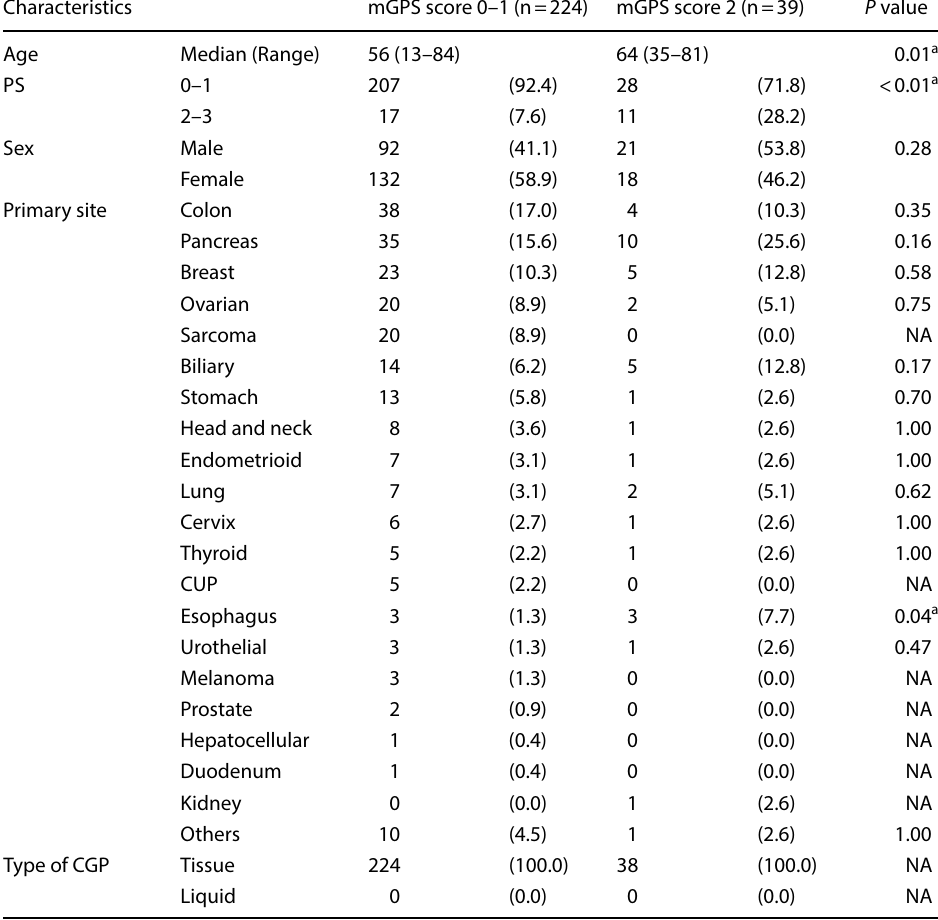
Table 1 Association of mGPS score with clinical